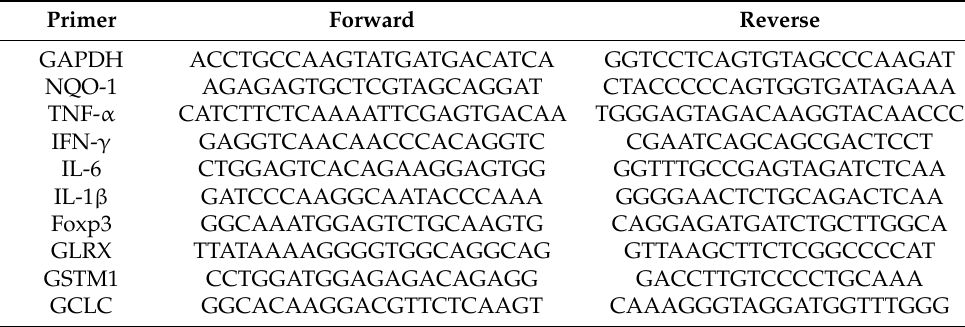
Table 2. Primers used in this